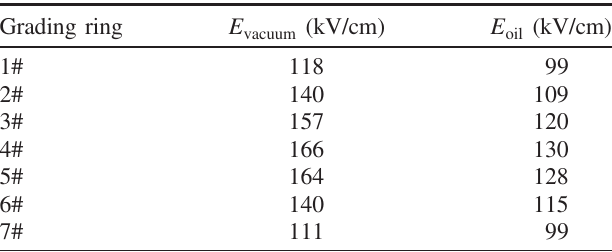
TABLE II. Maximum electric fields normal to the metal grading rings at the vacuum and oil